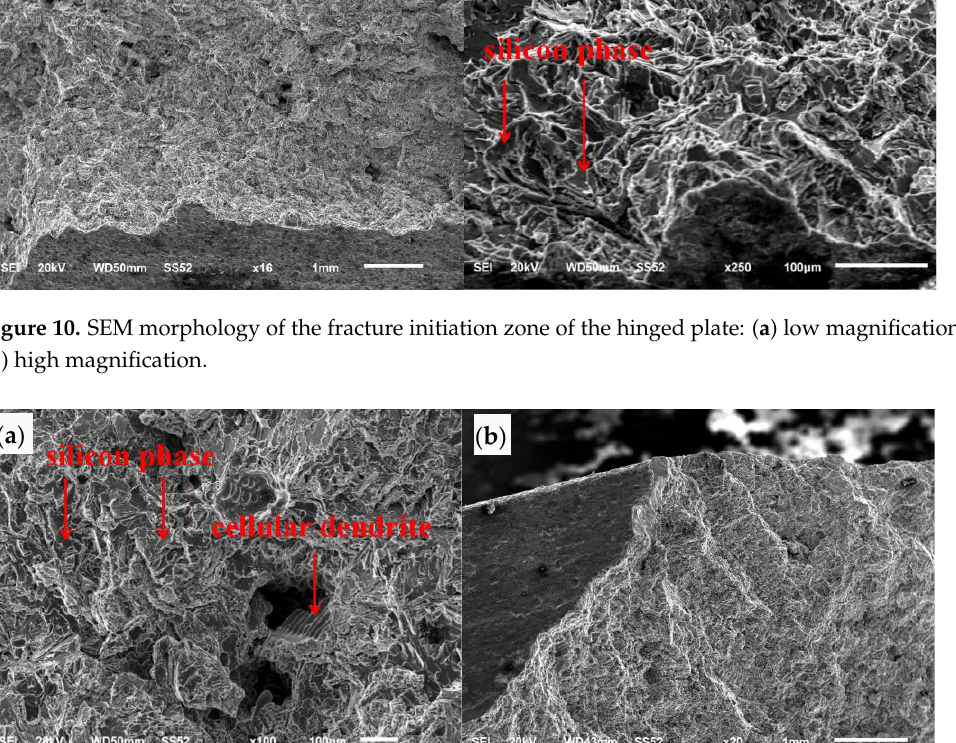
Figure 11. SEM morphology of the hinged plate: ( a ) fracture propagation region, ( b ) final fracture region.